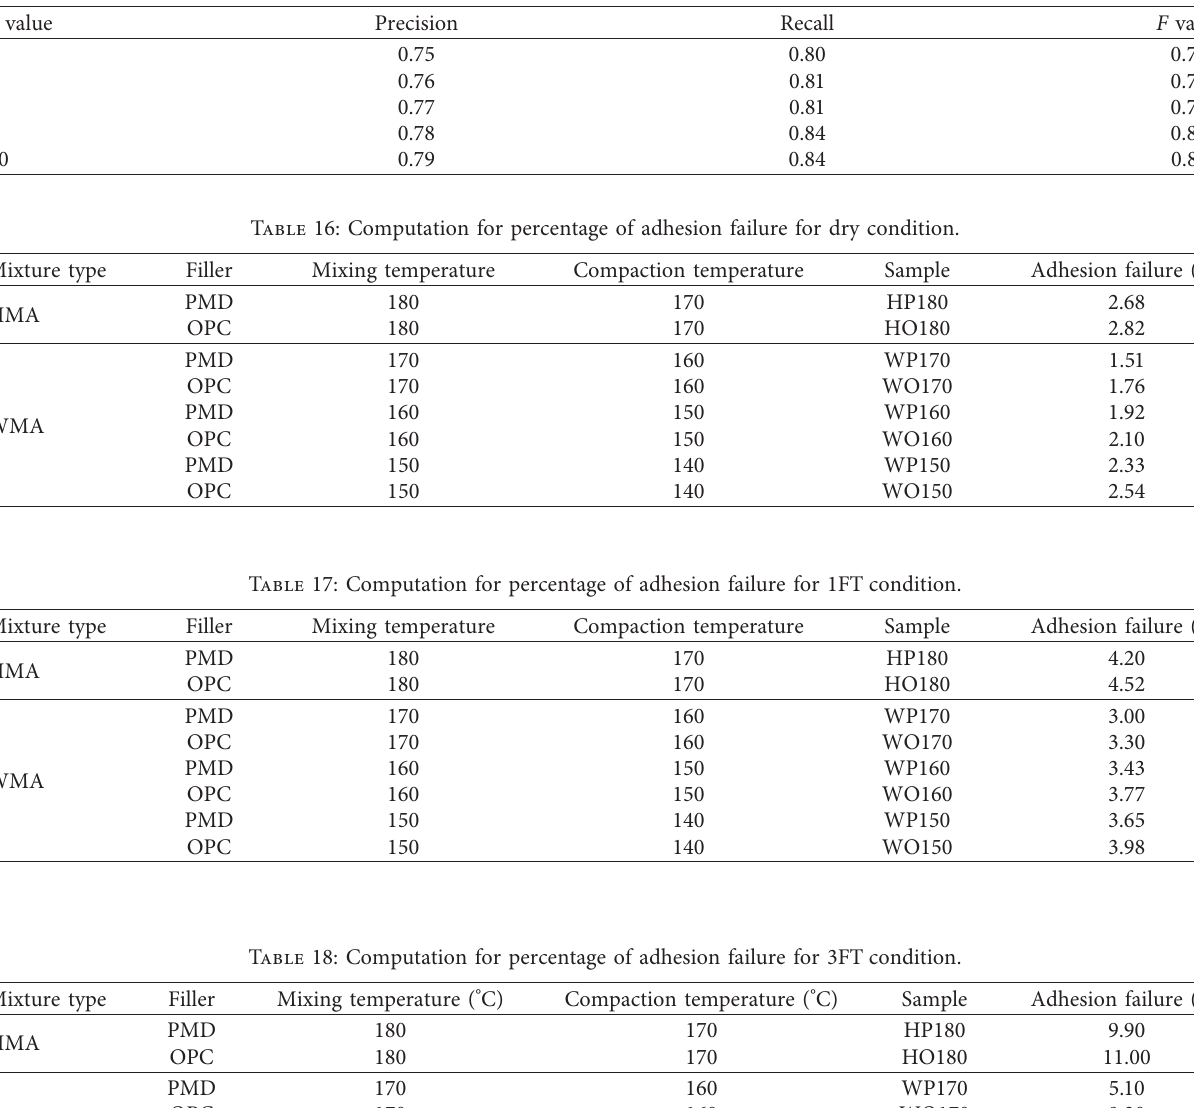
Table 15: Impact of k value on influencing parameters.